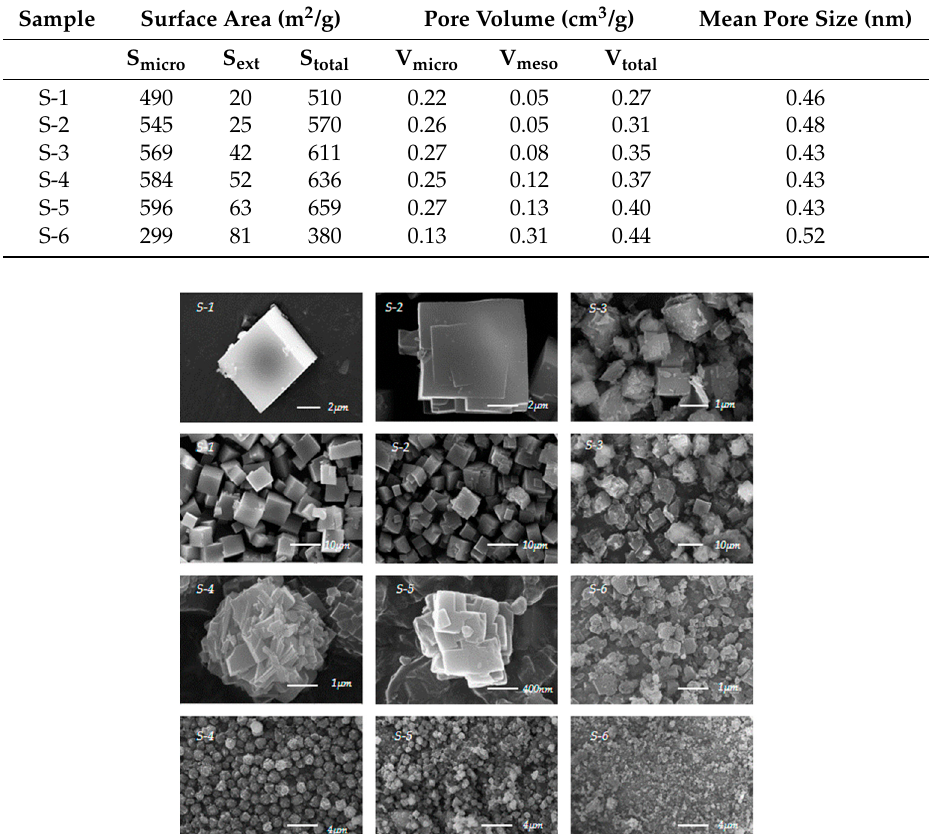
Figure 2. The SEM images of the prepared SAPO-34 samples.